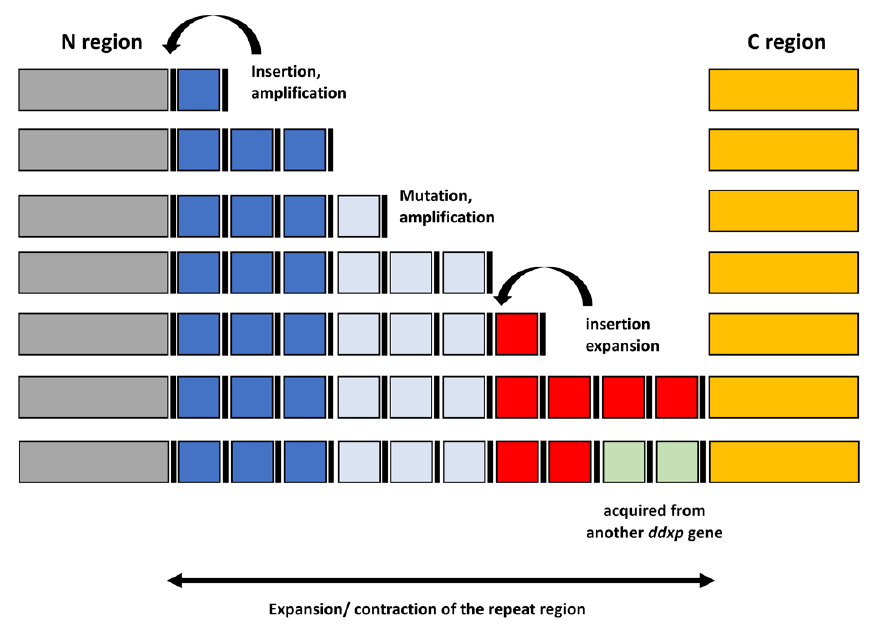
Figure 5. Step ‐ wise modification of ddxp genes. Insertion, mutation, and amplification of DNA modules coding DDxP repeats are sketched. Black bars denote TSDs.